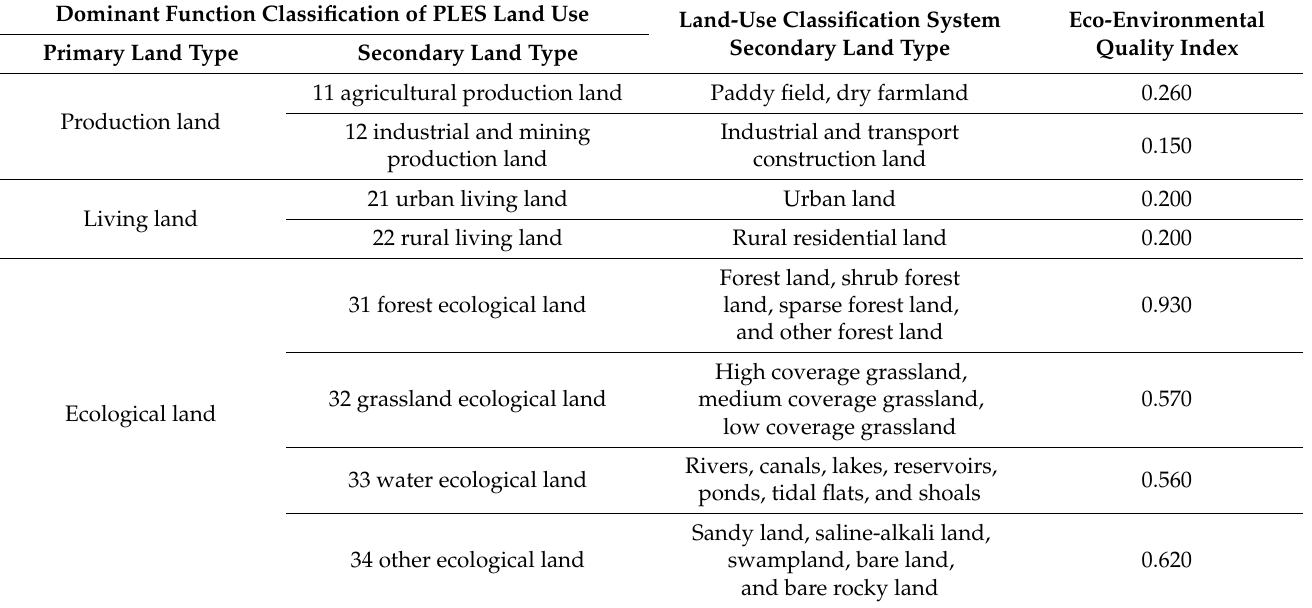
Table 2. Land-use classification for production–living–ecological land use and the eco-environmental quality